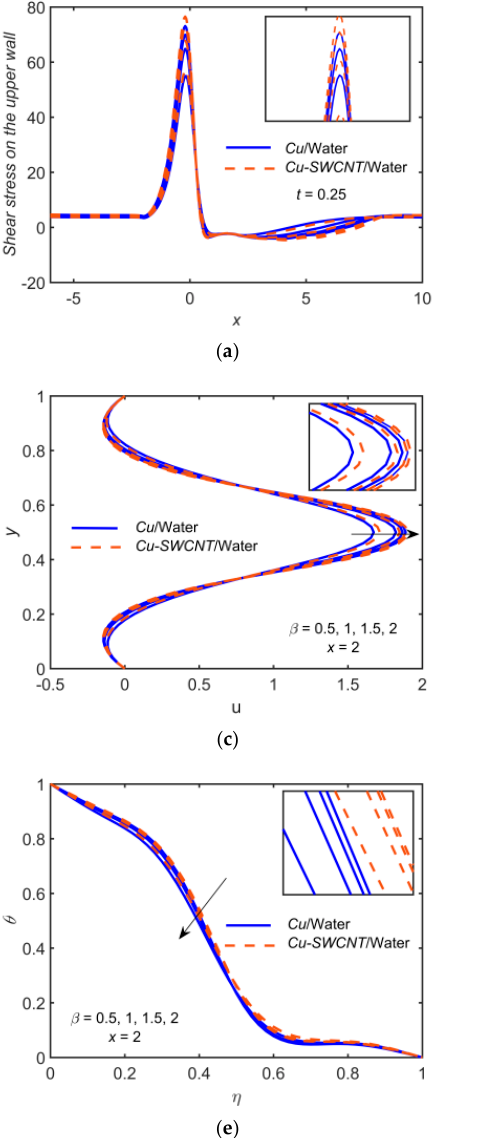
wall, (b) 𝑢 profile at 𝑥 = 0 , (c) 𝑢 profile at 𝑥 = 2 , (d) the temperature (𝜃) profile at 𝑥 = 0 , (e) the temperature (𝜃) profile at 𝑥 = 2 , and (f) the concentration (𝜑) profile at 𝑥 = 0 . Figure 6a shows that as 𝐷 (cid:3028) estimations intensify, the WSS on the upper wall reduces. The WSS for HNF is higher as compared to NF. Figure 6b,c show that the velocity field’s boundary layer thickness escalates as 𝐷 (cid:3028) grows and the velocity field reduces. The HNF velocity profile is slightly lower than that of the NF when 𝑥 = 0, but opposite behavior is noticed when 𝑥 = 2 . Figure 6d–f show that the 𝜃 and 𝜑 profiles escalate as 𝐷 (cid:3028) grows.